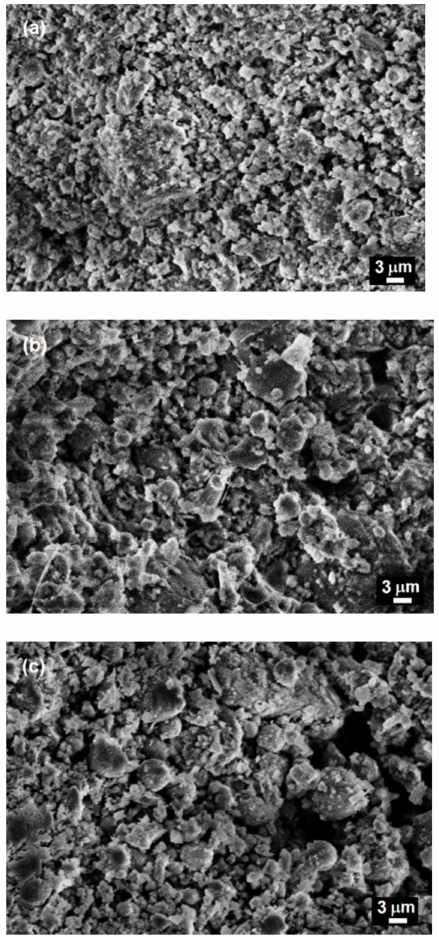
Figure 12. SEM images of the geopolymers cured for 360 d: GFA10D180 ( a ), GFA10D30 ( b ) and GFA1D30 ( c